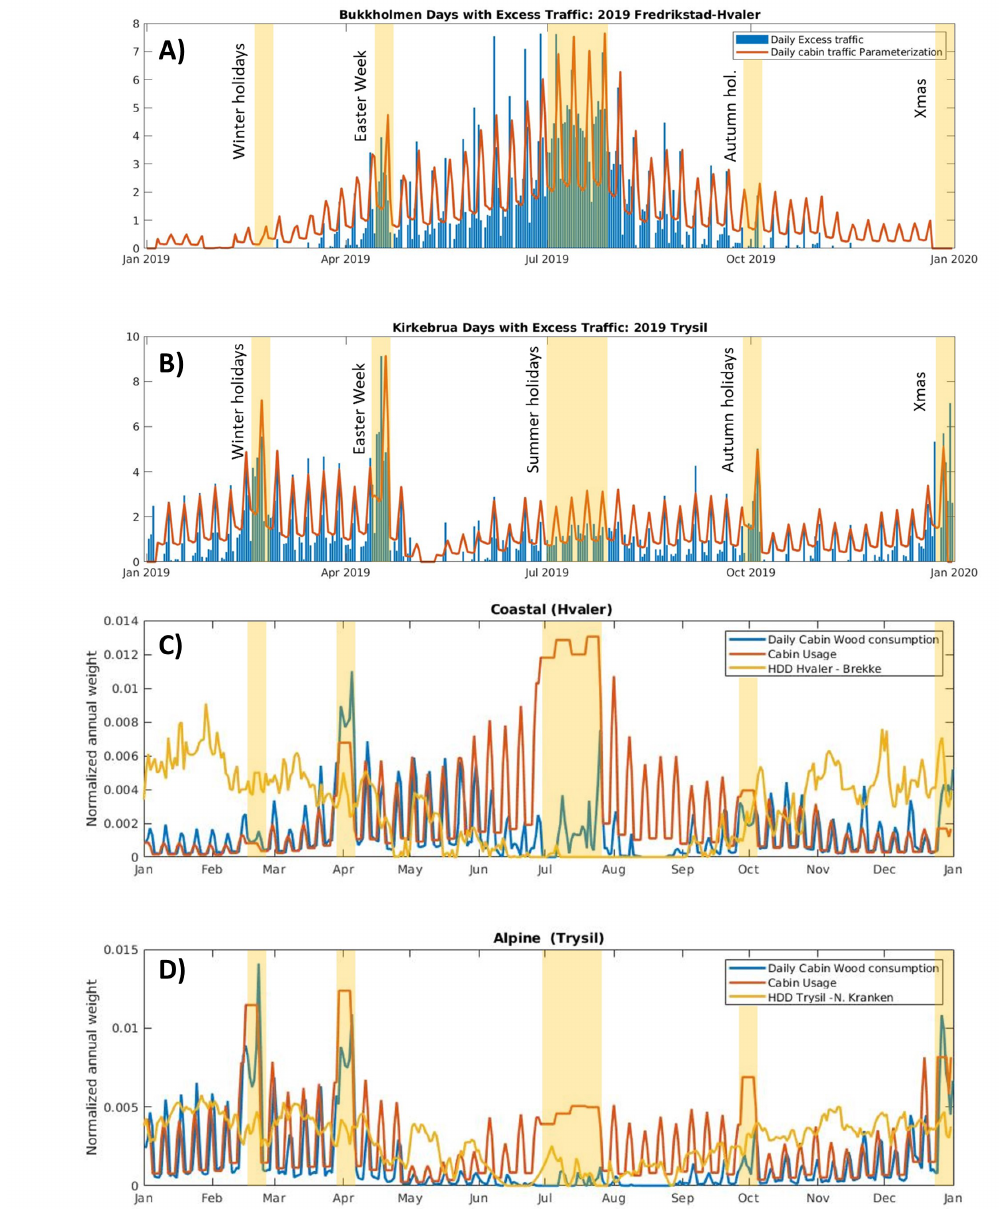
Figure 4. Daily excess traffic and cabin traffic at Hvaler ( A ) and Trysil ( B ). Cabin usage, daily wood consumption and HDD15 at Hvaler ( C ) and Trysil ( D ). Shaded areas represent holidays period; winter holidays, Eastern week, summer school holidays (July), Autumn holidays and Christmas. See text for more